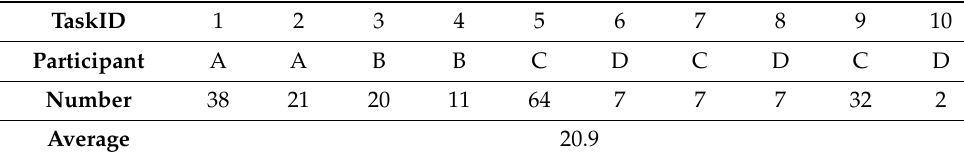
Table 2. Number of conceptions in the LAM use group.